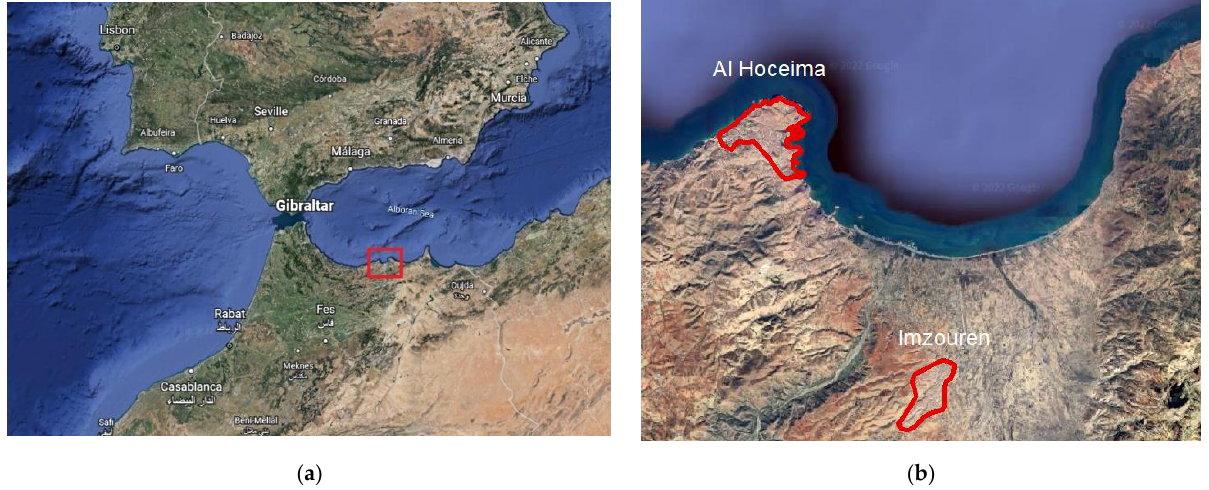
Figure 1. ( a ) Landsat satellite image of western Mediterranean (Google Earth) and location of the study area. ( b ) Satellite image (Google Earth) of the cities of Al Hoceima and Imzouren.